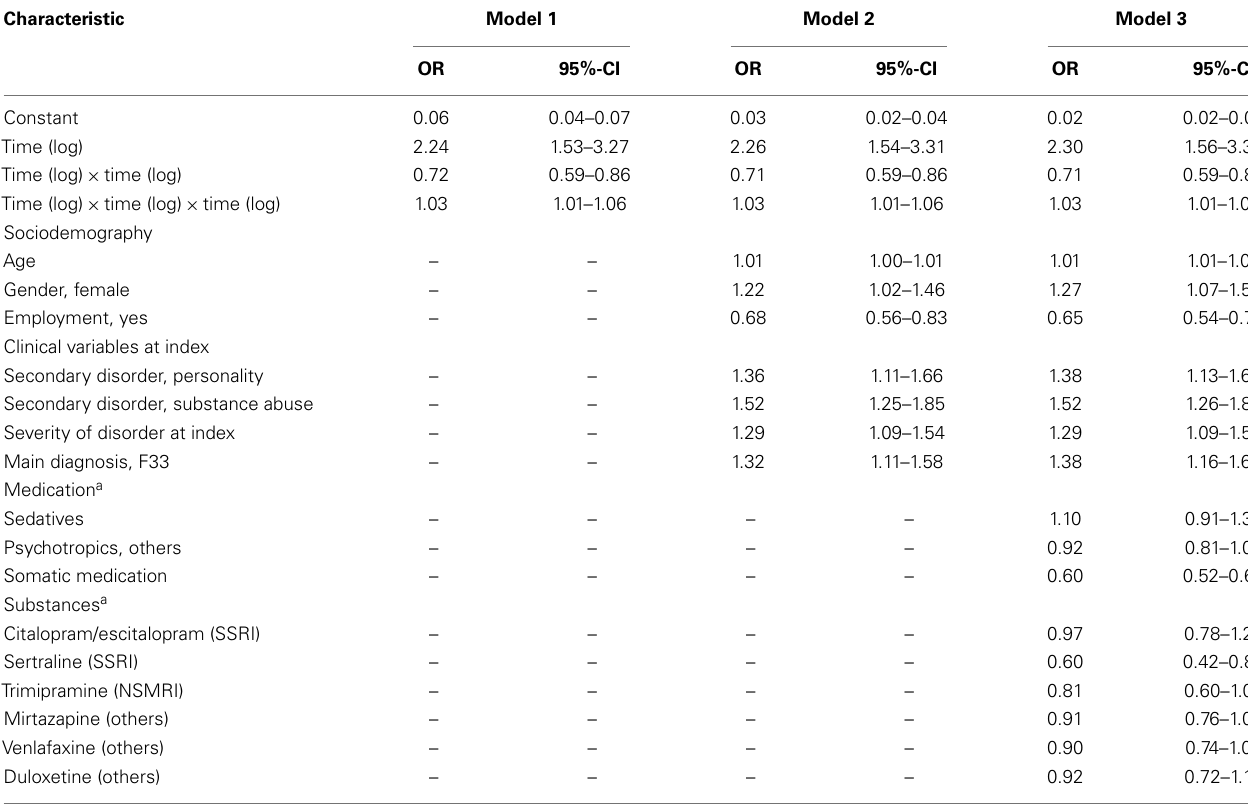
Table 3 | GEE model: predictors of being in hospital in a given week